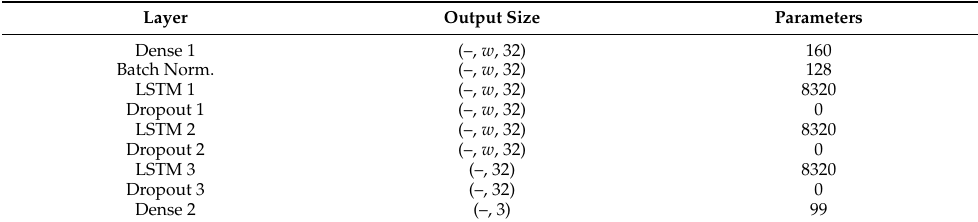
Table 4. Details of RNN